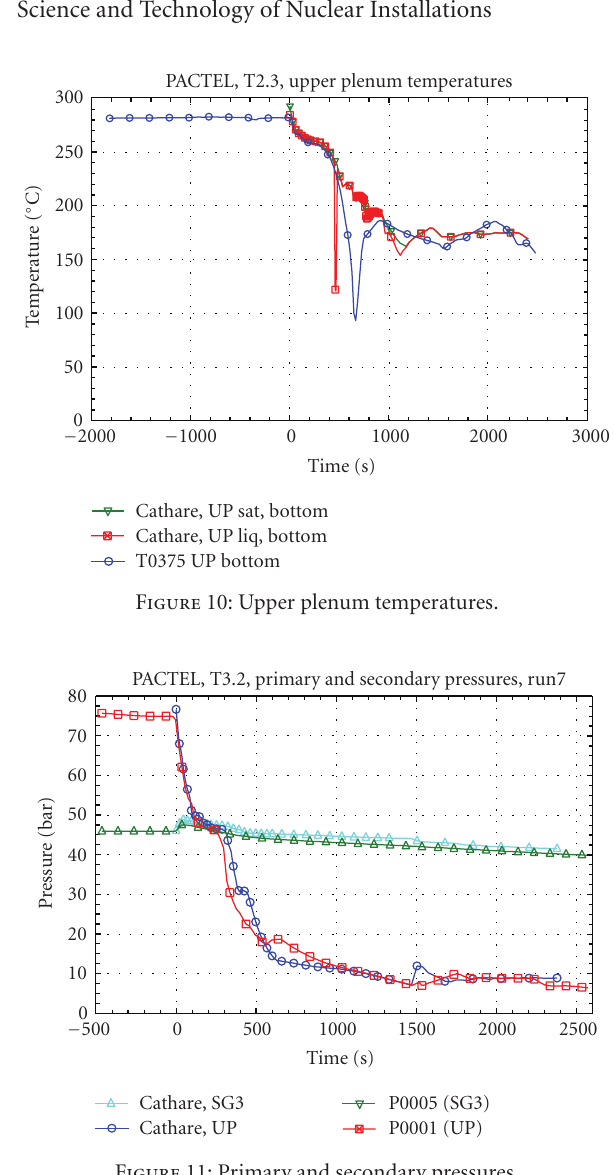
Figure 11: Primary and secondary pressures.